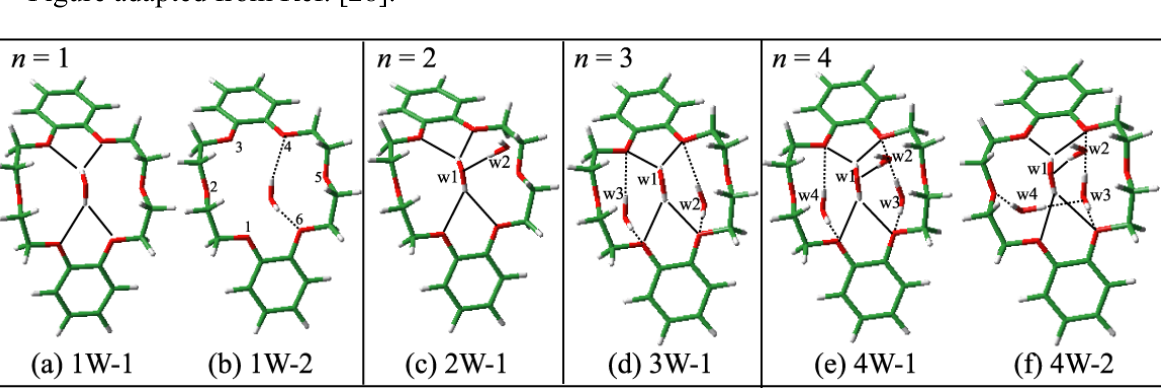
Figure 6. Optimized structures of DB18C6-(H represents a hypothetical probable structure. Solid lines denote H-bonds from the bottom side of the boat DB18C6, whereas dotted lines correspond to H-bonds from the top side. Figure adapted from Ref.